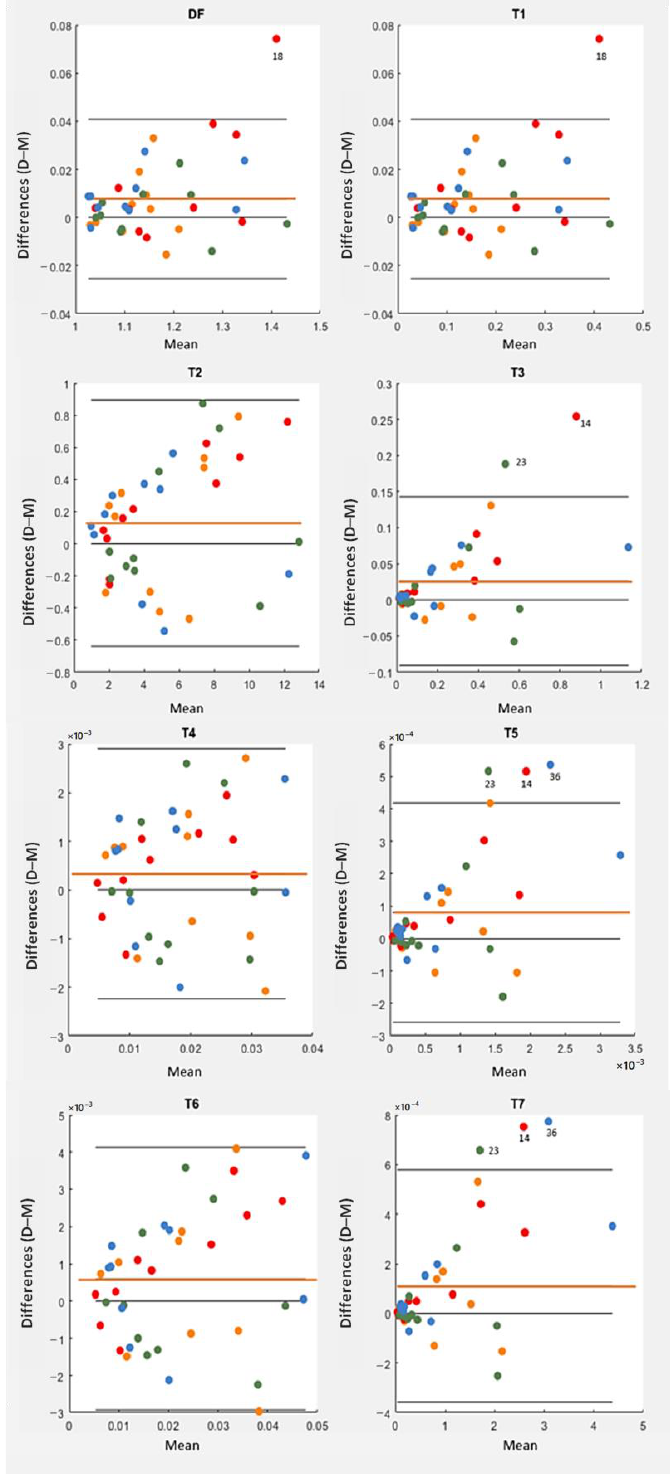
Figure 8. Bland –Altman plots for each tortuosity index (DF, T1 … T7). Differences between the values obtained in D-retinographies and the values obtained in M-retinographies are represented on the vertical axis. In each plot, the orange line represents the mean value of the individual differences. Points of the same color correspond to the same eye. Dot colors represent eye and subject, being MR1/DR1 (orange), ML1/DL1 (red), MR2/DR2 (green), ML2/DL2 (blue). Point 14 represents vessel 4 in ML1/DL1, point 18 vessel 8 in ML1/DL1, point 23 vessel 3 in MR2/DR2, and point 36 vessel 6 in